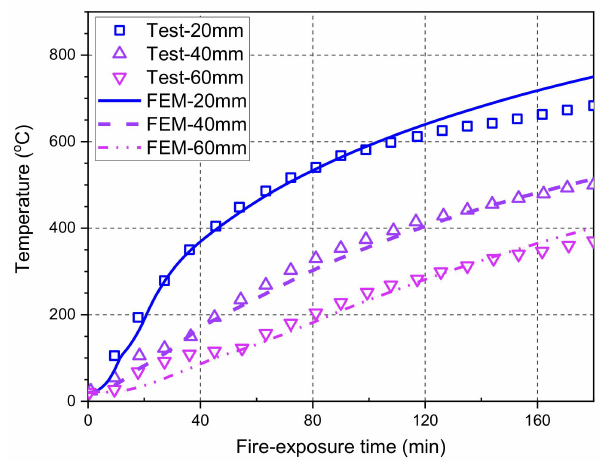
Figure 6. Temperature comparisons between the FE predictions and the measured